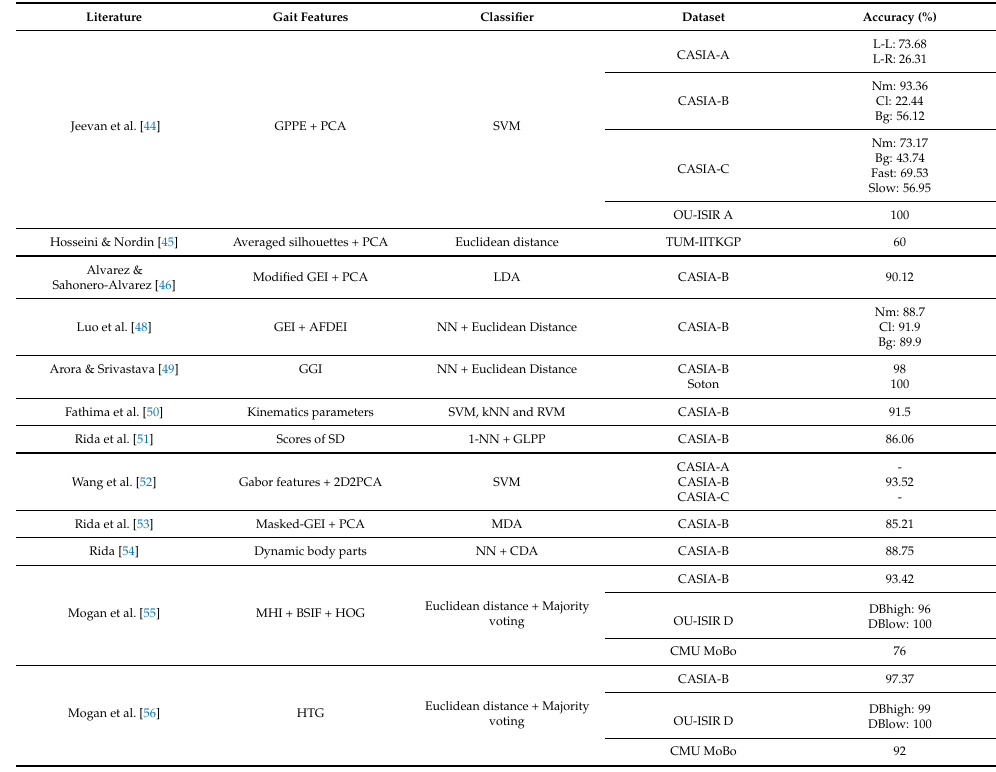
Table 2. Summary of model-free